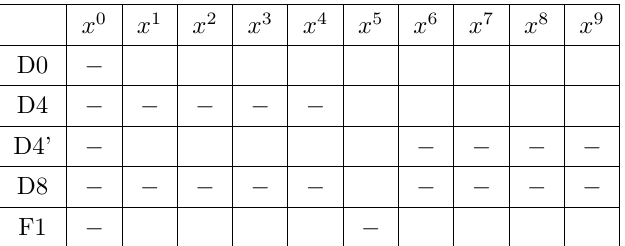
Table 1 . Brane set-up, where − marks the spacetime directions spanned by the various branes. x 0 corresponds to the time direction of the ten dimensional spacetime, x 1 , . . . , x 4 are the coordinates spanned by the CY , x 5 is the direction where the F1-strings are stretched, and x 6 , x 7 , x 8 , x 9 are 2 the coordinates where the SO (4) symmetry is